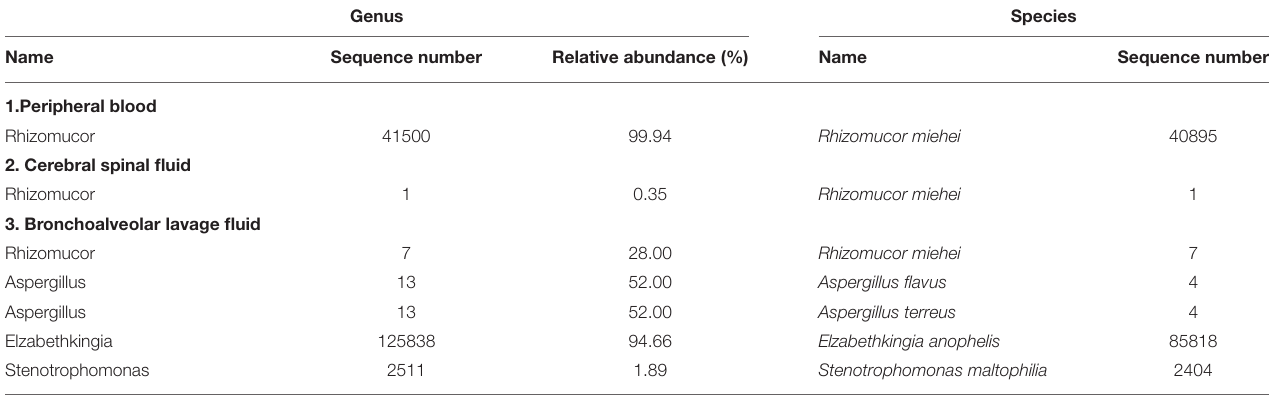
TABLE 1 | Pathogenic microorganisms detected in peripheral blood, cerebral spinal fluid, and bronchoalveolar lavage fluid specimen of patient by next-generation sequencing. Genus